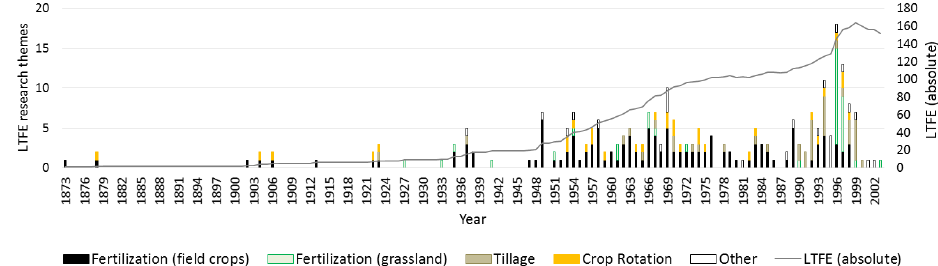
Figure 3. Number of LTFEs set up per year according to the research themes of the experiments (multiple nominations possible, n = 251) and total number of LTFEs per year (meaning established LTFE minus terminated